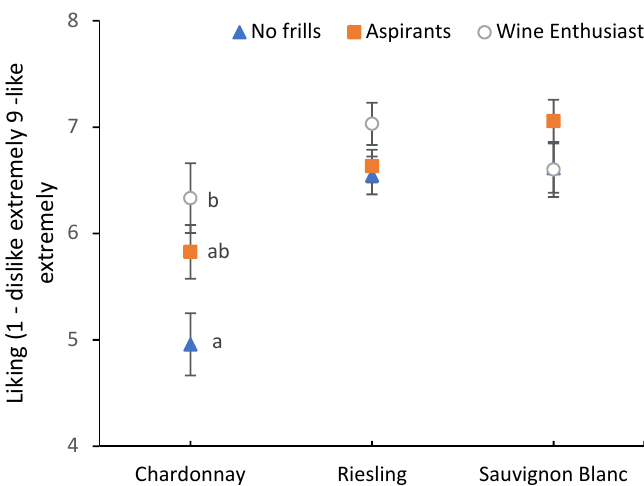
Figure 1. Hedonic responses of the fine wine segments (FWS) towards the three wine samples, pooled for information conditions. Liking ratings were measured on a 9-point hedonic-scale, ranging from 1 = dislike extremely to 9 = like extremely. Error bars indicate standard errors. Different lowercase letters indicate significant differences between FWS based on Fishers least significant difference (LSD) post-hoc comparisons.